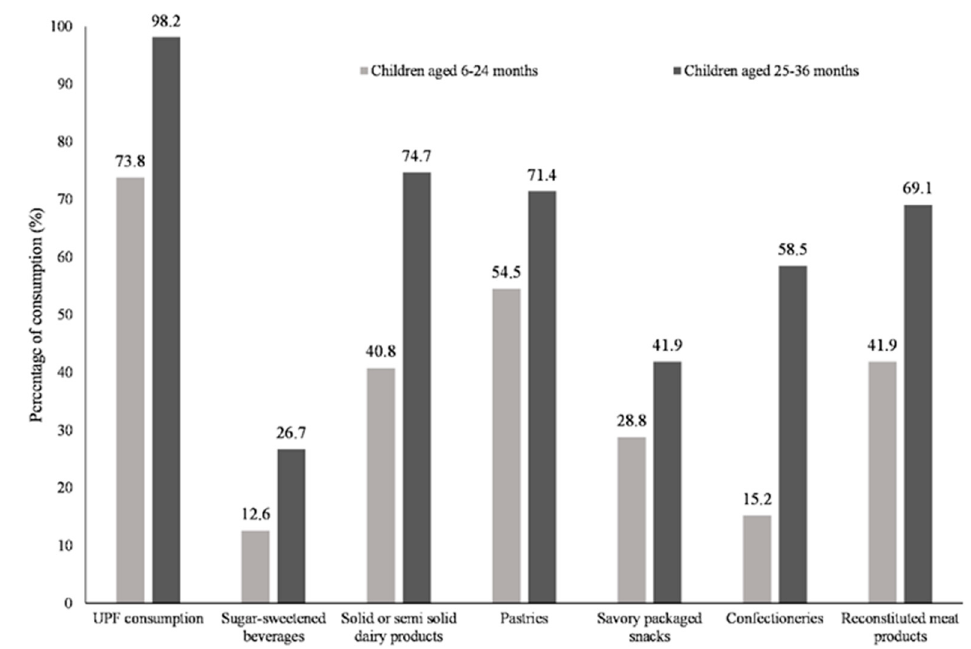
Figure 2. The consumption of UPF by children aged 6–24 months ( n = 191) and children aged 25–36 months ( n = 217). UPF: ultra-processed foods. The percentages of consumption of UPF, as well as each UPF item, were different between children aged 6–24 months and children aged 25–36 months ( p < 0.05). ( p <